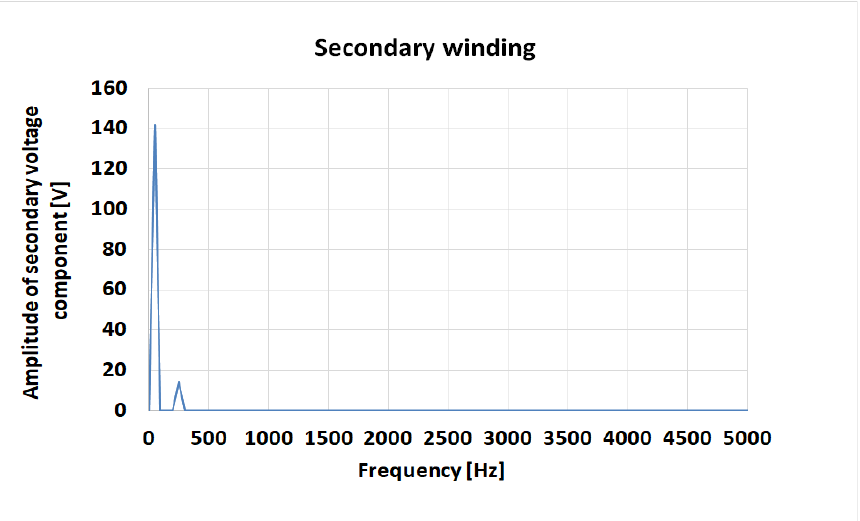
Figure 8. Discrete Fourier analysis of the sum of the cosines of the secondary voltage of the voltage transformer calculated using the field method (primary voltage consists of the first harmonic 50 Hz 100% and the fifth harmonic 250 Hz 10%).